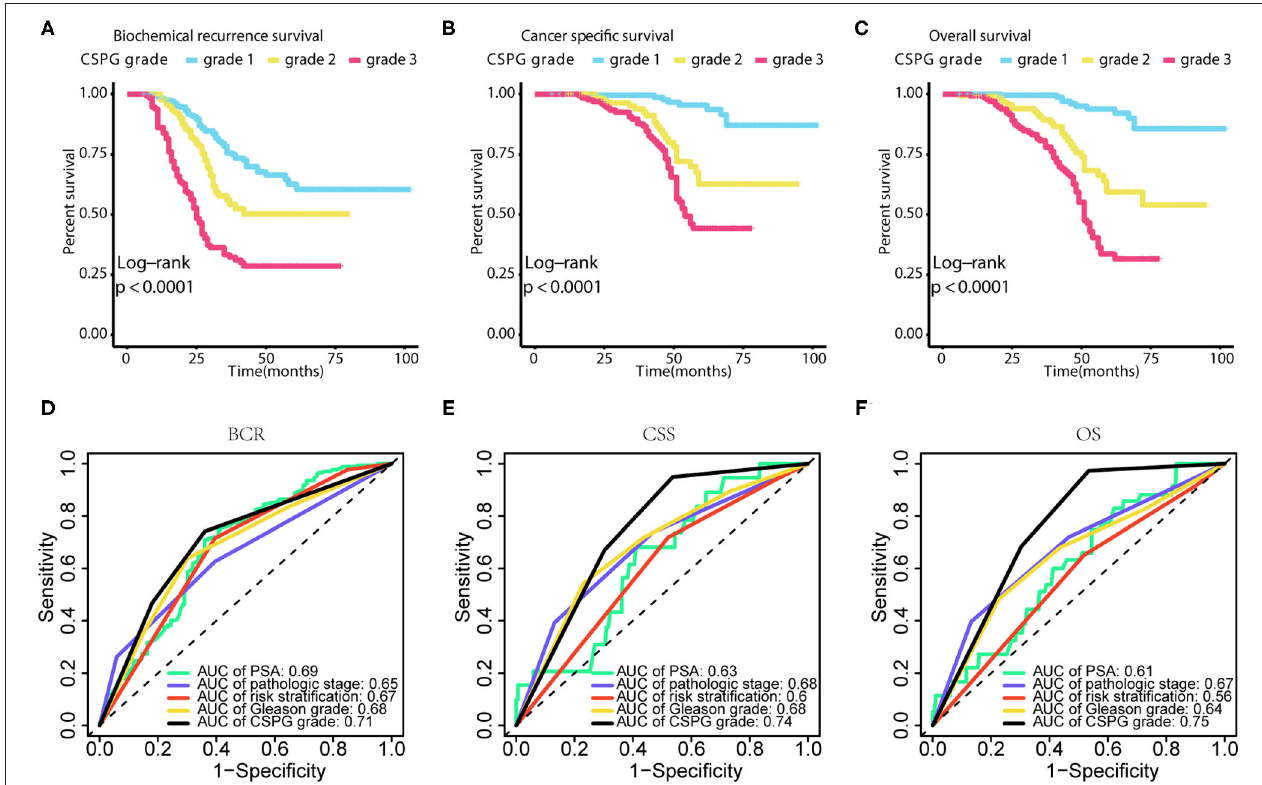
FIGURE 3 | Survival curves and tdROCs of combined cysteine rich secretory protein 3 (CRISP3) and serine peptidase inhibitor Kazal type 1 (SPINK1) prognostic grade (CSPG) based on different survival events. These survival curves reveal that BCR [ (A) , log-rank test P < 0.0001], CSS [ (B) , log-rank test P < 0.0001], and OS [ (C) , log-rank test P < 0.0001] worsen with increased CSPG grade. And these tdROCs reveal that the accuracy of CSPG was highest in 3-year tdROC compared with others clinical parameters for BCR [ (D) , AUC = 0.71], CSS [ (E) , AUC = 0.74], and OS [ (F) , AUC = 0.75]. TdROC, time-dependent receiver operating characteristic curve; BCR, biochemical recurrence; CSS, cancer-specific survival; OS, overall survival.